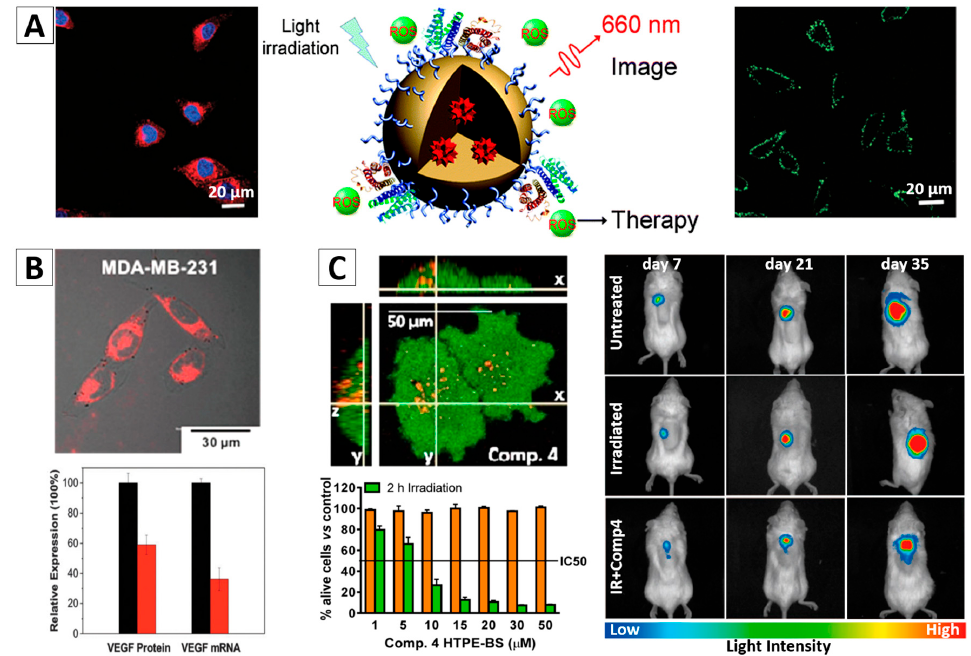
Figure 8. AIE NPs with cRGD ( A ) and siRNA ( B ) functionalized surface for targeted imaging and image-guided photodynamic therapy (PDT) [92,94]; ( C ) CLSM images of PC3 cell after an overnight incubation with TPE-NPs of Comp 4 (TPE-benzothiazole conjugates hexyl); Concentration dependent cytotoxicity of Comp 4 in PC3 cells in dark (orange bars) and light (green bars) conditions; and representative non-invasive bioluminescence images of PLuc-expressing PC-3 tumors [93]. Reprinted with permission from [92–94]. Copyright 2014 The Royal Society Chemistry, Copyright 2016